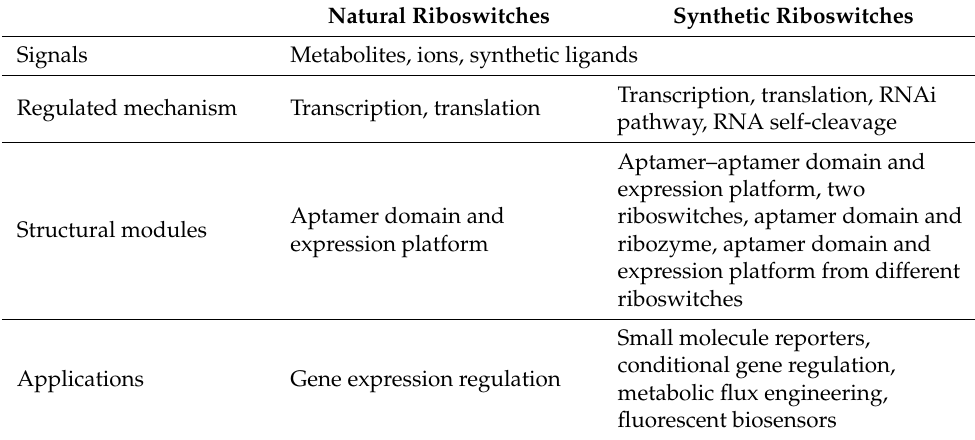
Table 2. Characteristics of natural and synthetic